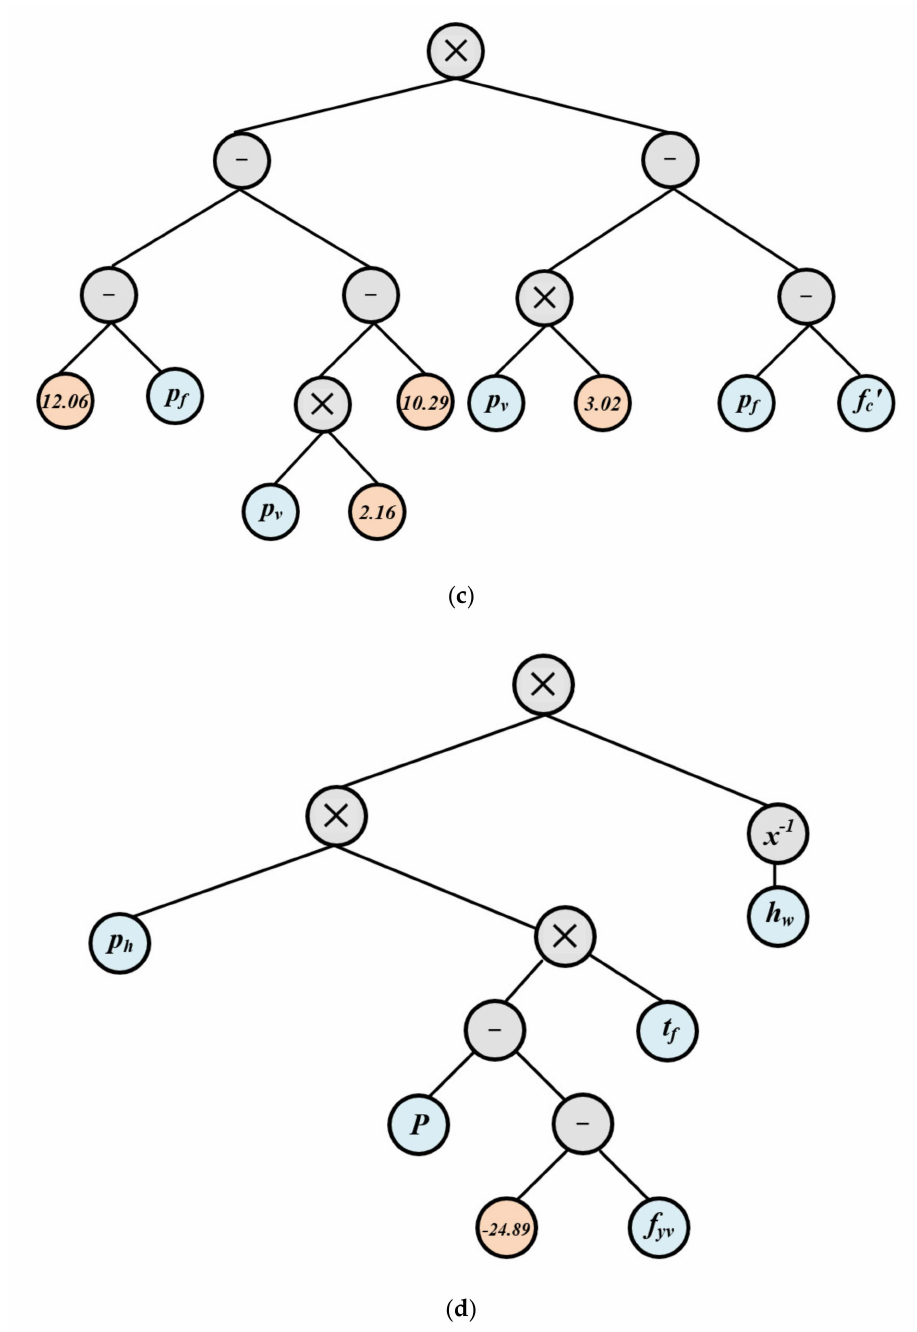
Figure 3. Gene Expression Tress ( a ) Sub-ET 1 ( b ) Sub-ET 2 ( c ) Sub-ET 3 ( d ) Sub-ET